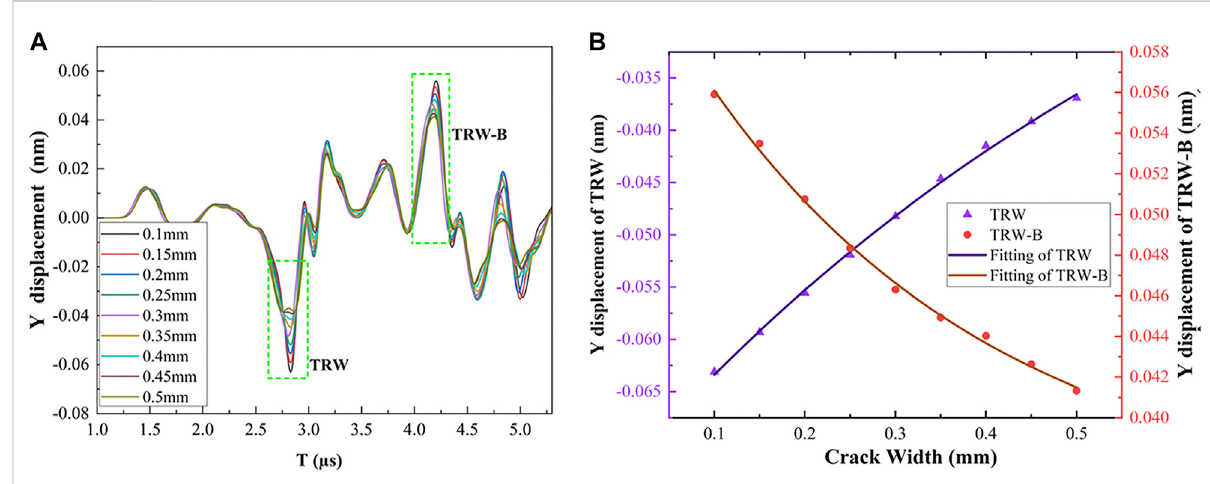
FIGURE 12 Y displacement and Fitting curves: (A) Different widths on the opposite side; (B) Fitting curve of TRW (purple) and TRW-B